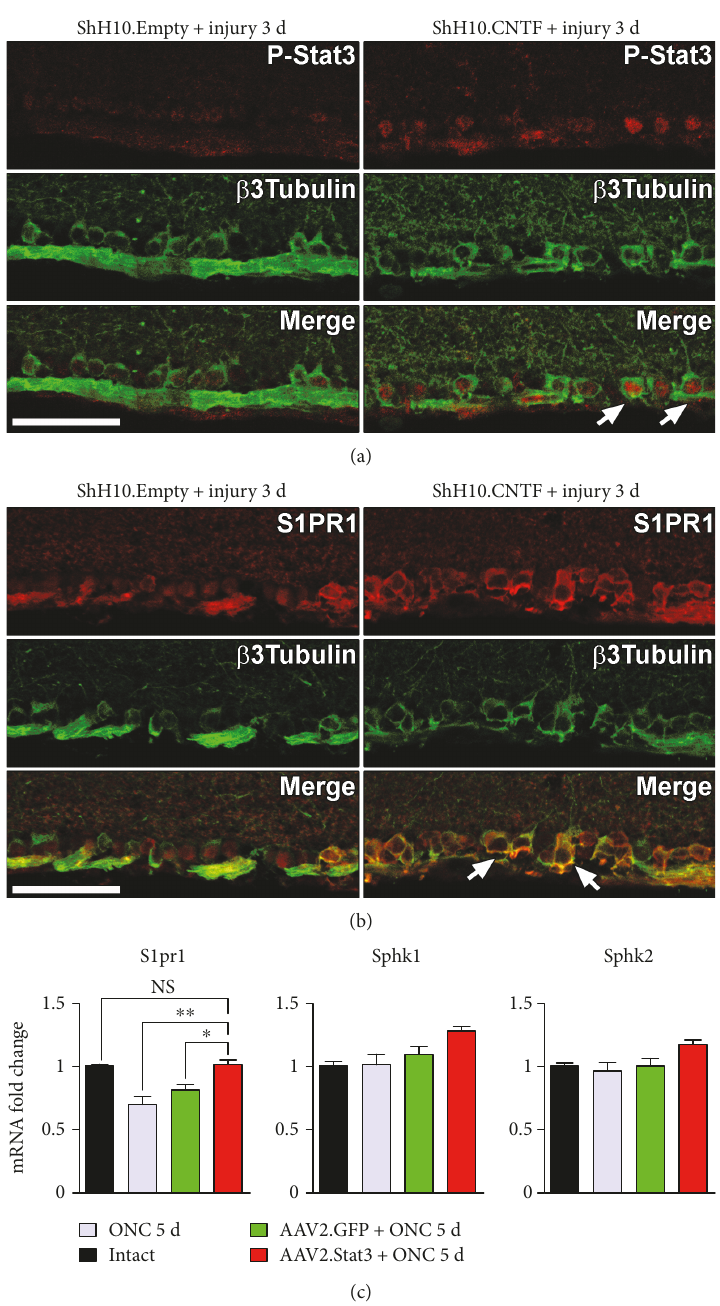
Figure 3: Modulation of S1PR1 expression by the CNTF/Stat3 pathway in optic nerve-injured retinae. (a, b) S1PR1 expression changes were monitored 3 d after ONC in retinae infected with ShH10.CNTF or ShH10.Empty, a control vector that was deprived of cDNA sequence. ShH10 viruses preferentially infected Müller glia in the retina [16]. P-Stat3 and S1PR1 were markedly increased by ShH10.CNTF in RGC somata identi fi ed using β 3-tubulin as a speci fi c marker. (c) Five days after ONC, qRT-PCR measurements showed that the infection of RGCs with AAV2.Stat3 signi fi cantly increased the mRNA level of S1pr1 compared with control AAV2.GFP vector. ShH10 and AAV2 viruses were intravitreally injected 4 weeks before ONC. Three mice were analyzed/grouped. Statistics: one-way ANOVA; ∗ p < 0 05 , ∗∗ p < 0 01 ; NS: not signi fi cant. Scale bar: 50 μ